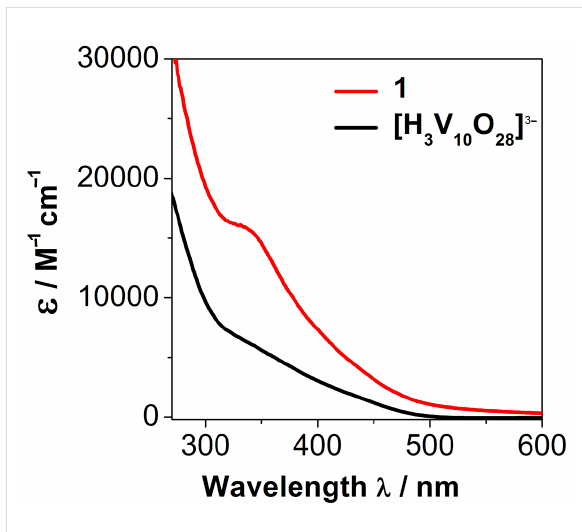
Figure 1: UV–vis spectroscopic data for the bismuth vanadium oxide cluster H 3 [{Bi(dmso) 3 } 4 V 13 O 40 ] ( 1 , red line). The compound features a near-visible LMCT absorption band with ε 335 = 15940 M − 1 cm − 1 . In contrast, the pure vanadium oxide cluster [H 3 V 10 O 28 ] 3 − features significantly reduced visible-light absorption (black line).